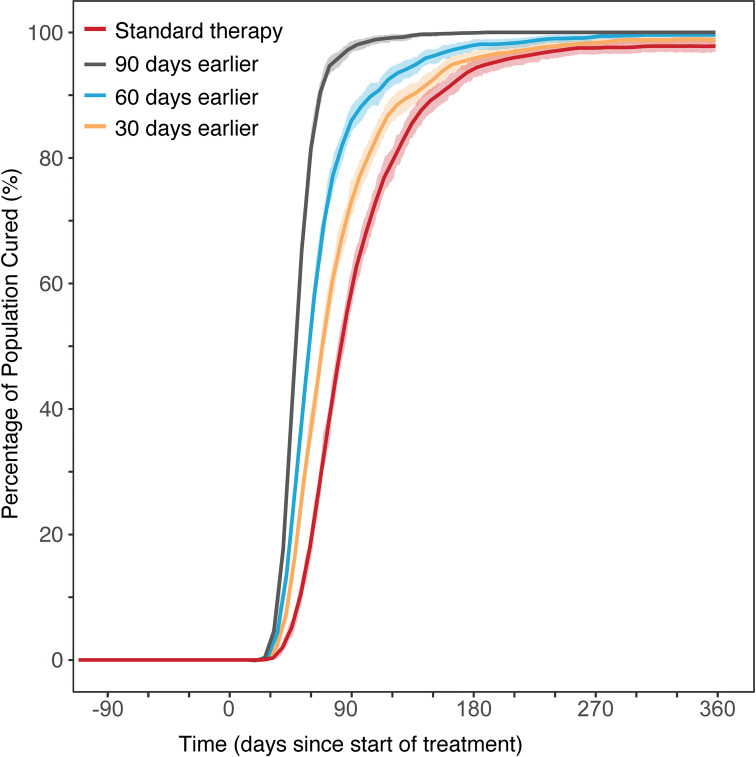
Population TB treatment outcome for different treatment start scenarios.Comparison of median patient outcomes for treatment of TB infection, with standard drug therapy (2HREZ/4HR) of earlier diagnosis and the impact on patient outcomes if treatment is started earlier. Based on simulation of 5000 patients. Shaded areas show the 95 percentile range of the simulations.